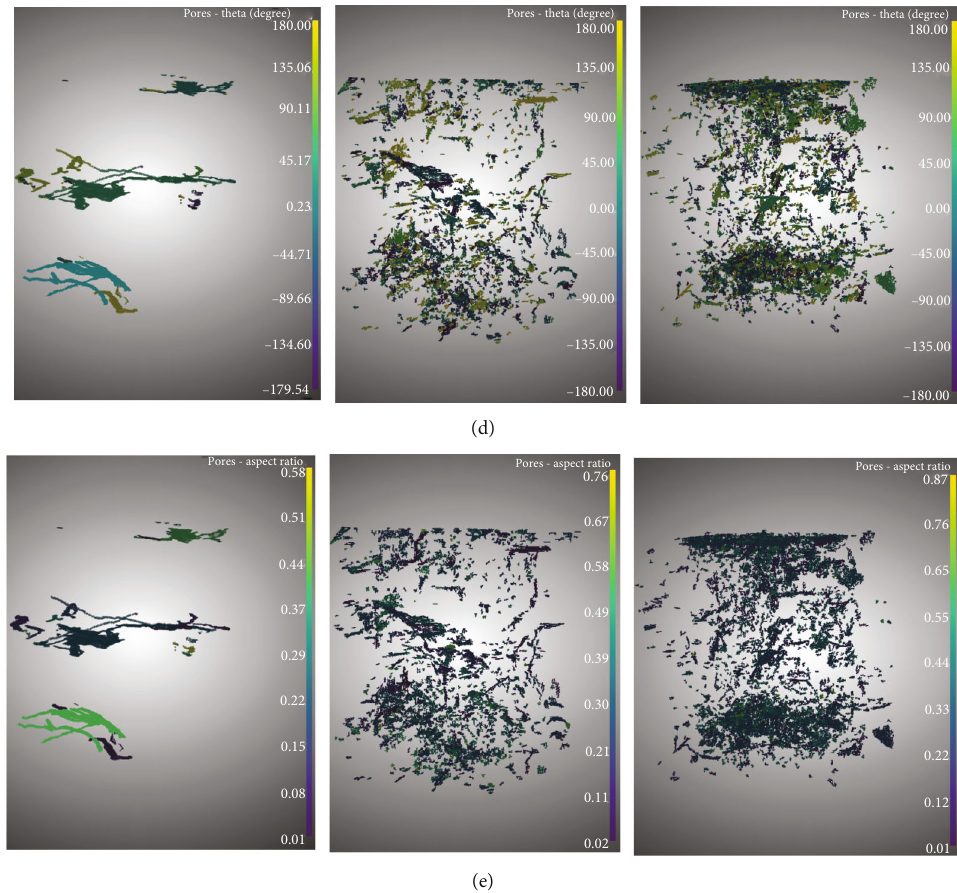
Figure 13: Pore space and geometric distribution under di ff erent wet and dry times: (a) volume, (b) surface area, (c) Phi, (d) Theta, and (e) diameter-length